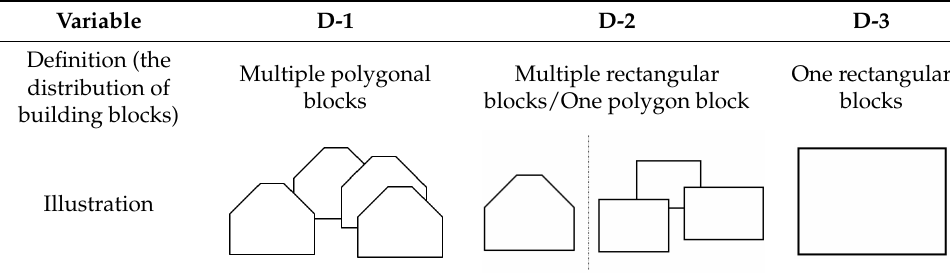
Table 4. Criteria of the distribution of building blocks.